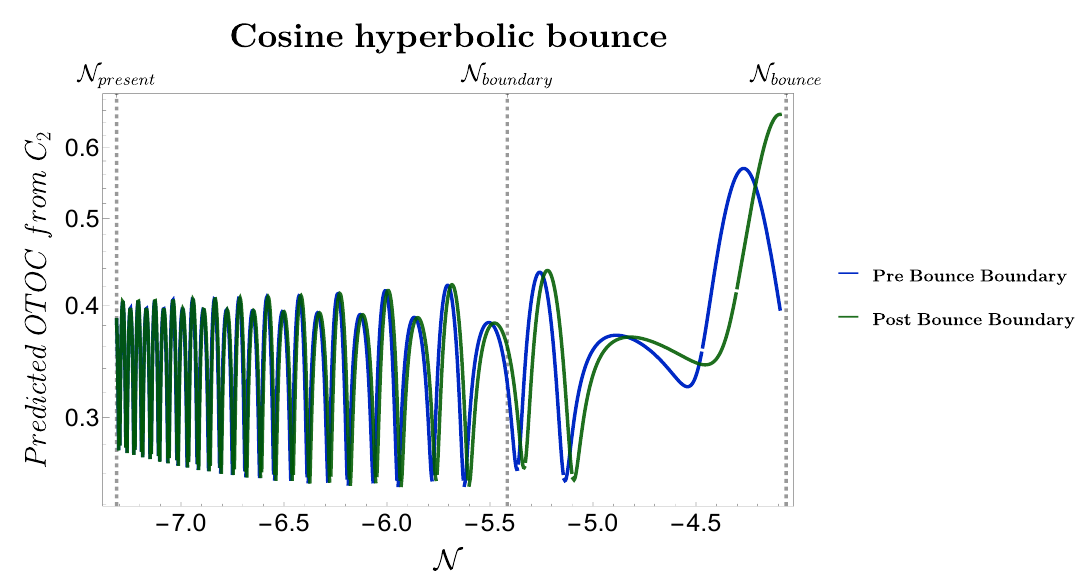
Figure 25: Predicted OTOC from geodesically weighted complexity outside bouncing region with respect to number of e-foldings.